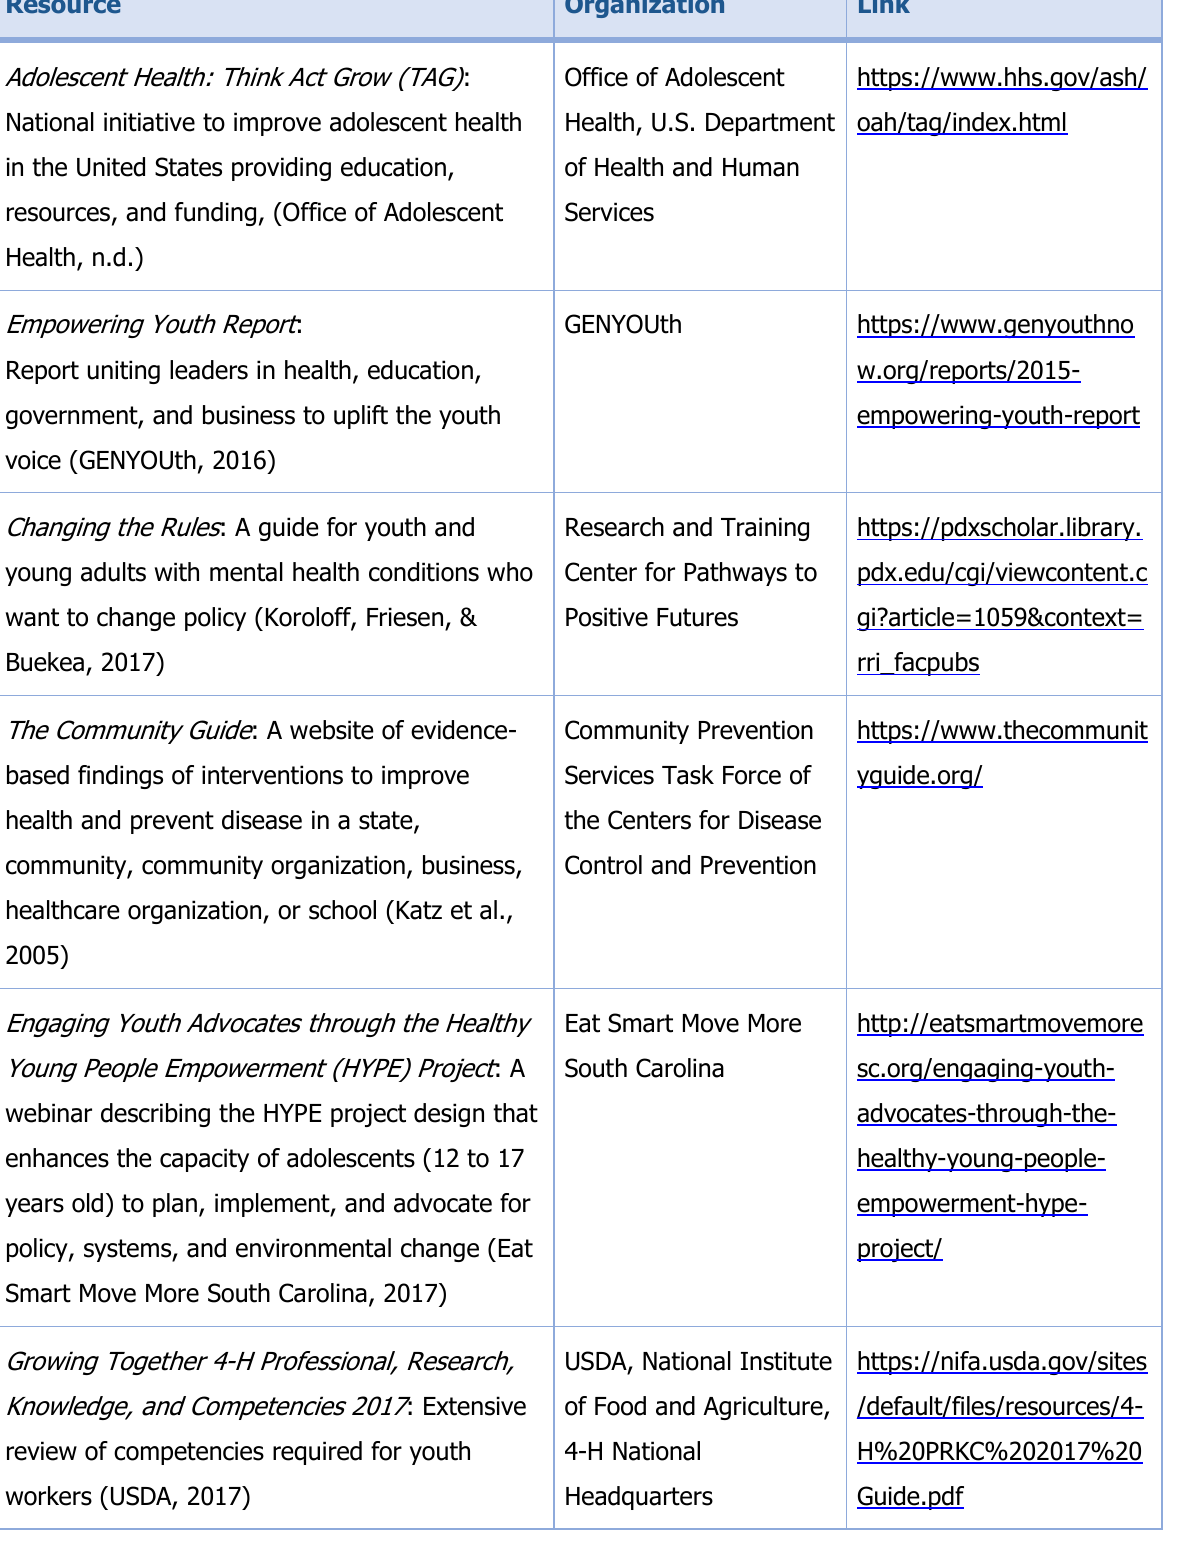
Table 1. PYDH Competency-Building Resources to Support Youth Health Advocates